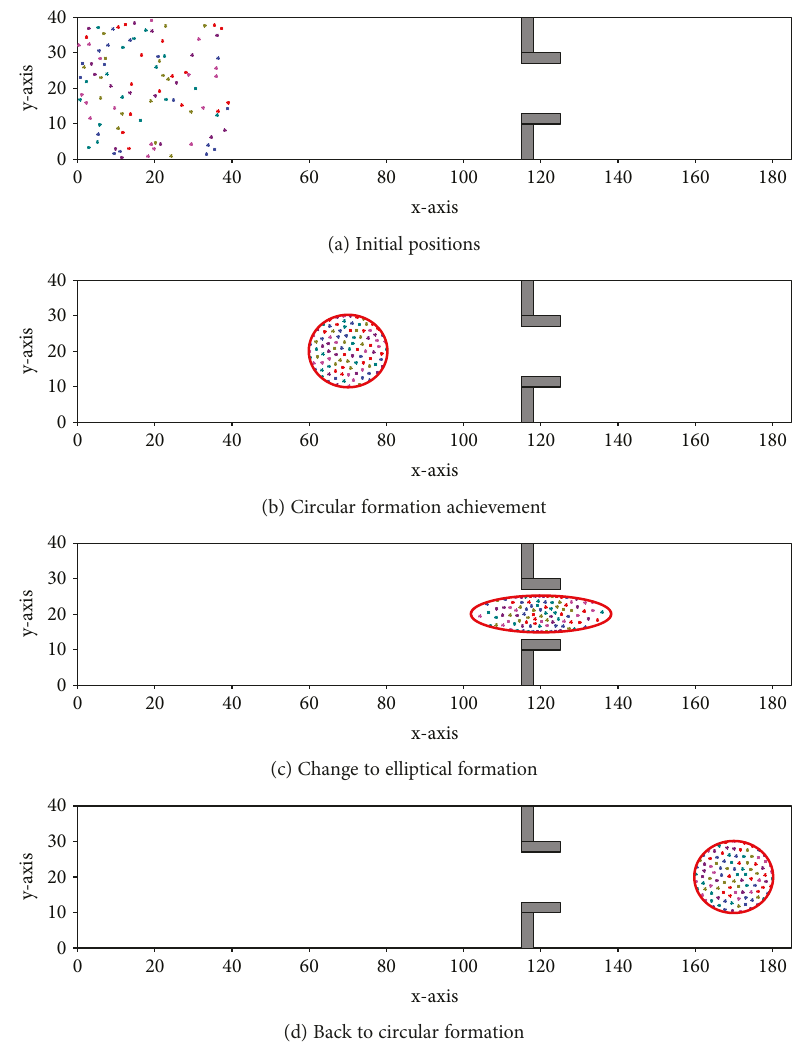
Figure 1: Change of the formation shape for passing the narrow